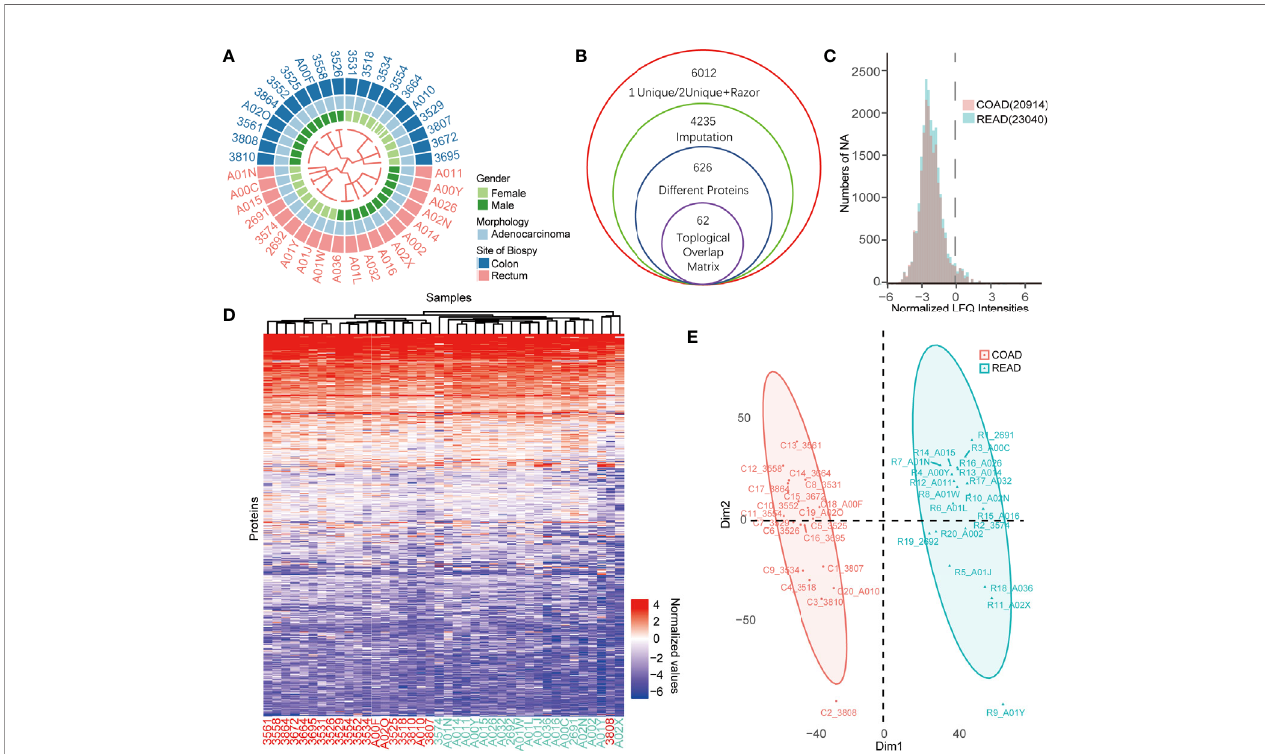
FIGURE 1 | Comparative proteomics analysis of colon adenocarcinoma (COAD) and rectal adenocarcinoma (READ). (A) The heatmap exhibited overview of patients ’ characters including gender, morphology, site of biopsy using binary cluster. (B) The work fl ow of differential expressed proteins (DEPs) screening was displayed. (C) The histogram showed the numbers of missing values of the COAD and READ. (D, E) K-means cluster analysis (D) and principal component analysis (PCA) (E) of COAD and READ showed signi fi cant difference of proteins expression pro fi les between the two